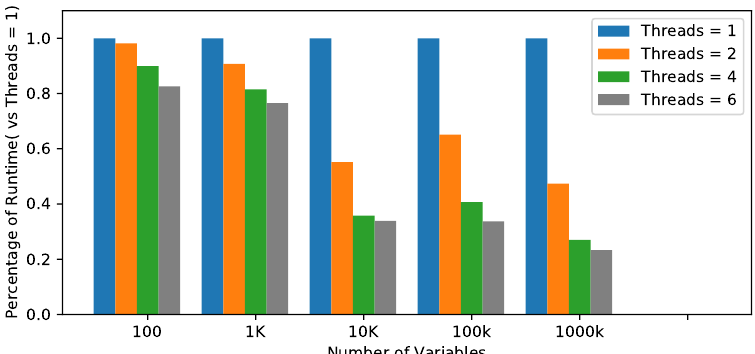
Figure 6. Sensitivity evaluation w.r.t. the number of parallel threads.